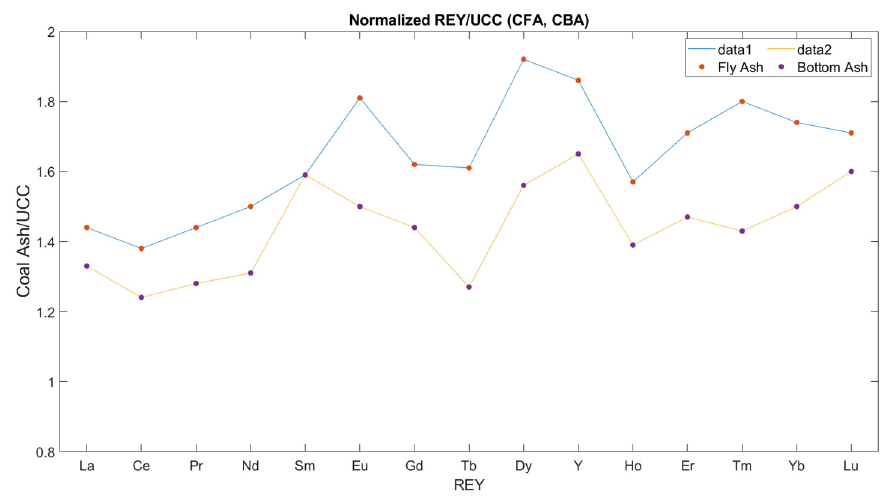
Figure 1. REY Distribution Pattern of the Fly and Bottom Ash